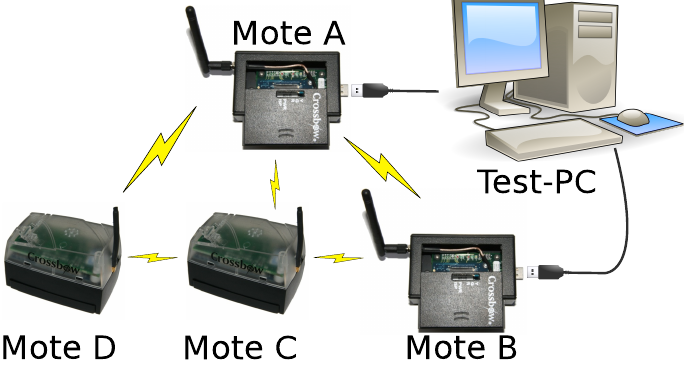
Figure 4. Configuration of the four-mote test